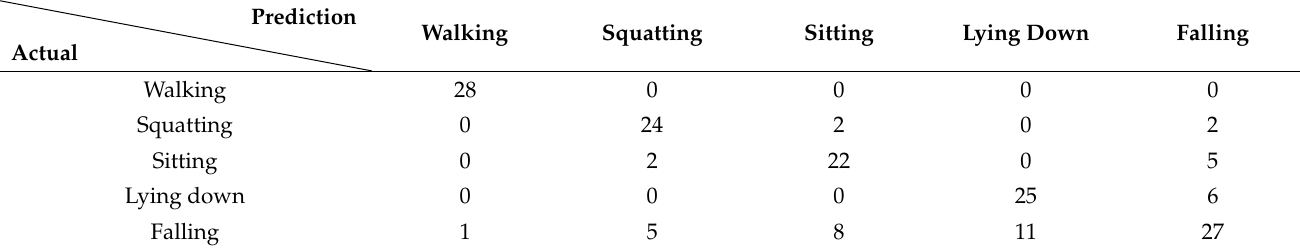
Figure 18. Representative recognition results from the video of a falling elderly man: ( a ) Frame 218